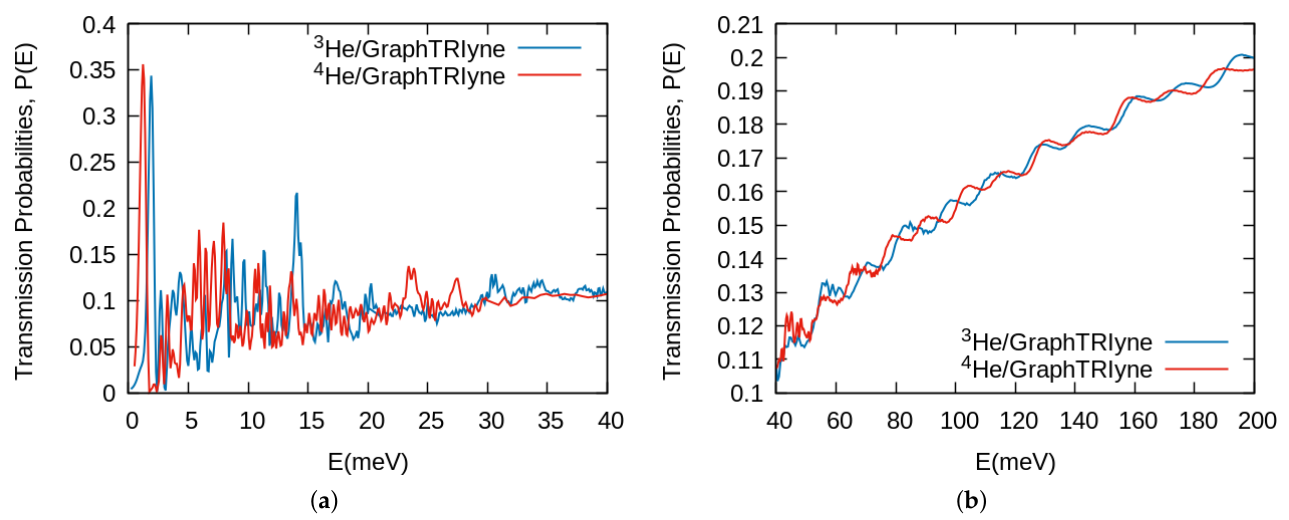
Figure 3. 4 He and 3 He transmission probabilities as a function of the kinetic energy in ( a ) low energy regime, ( b ) at higher kinetic